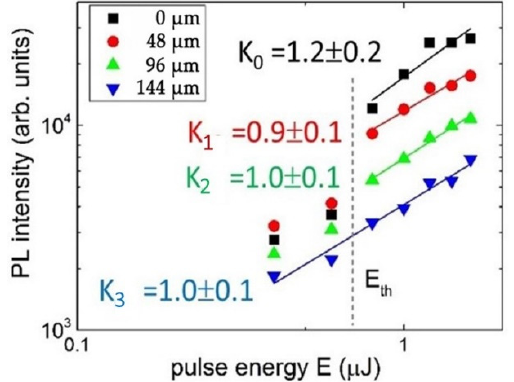
Figure 3. Peak intensity of the NV − band at 685 nm at different depths versus incident 0.3 ps laser pulse energy in log–log coordinates as well as the linear fitting lines of these curves with their slopes, K 0 (depth—0 µ m), K 1 (depth—48 µ m), K 2 (depth—96 µ m) and K 3 (depth—144 µ m), and the threshold energy, E th .